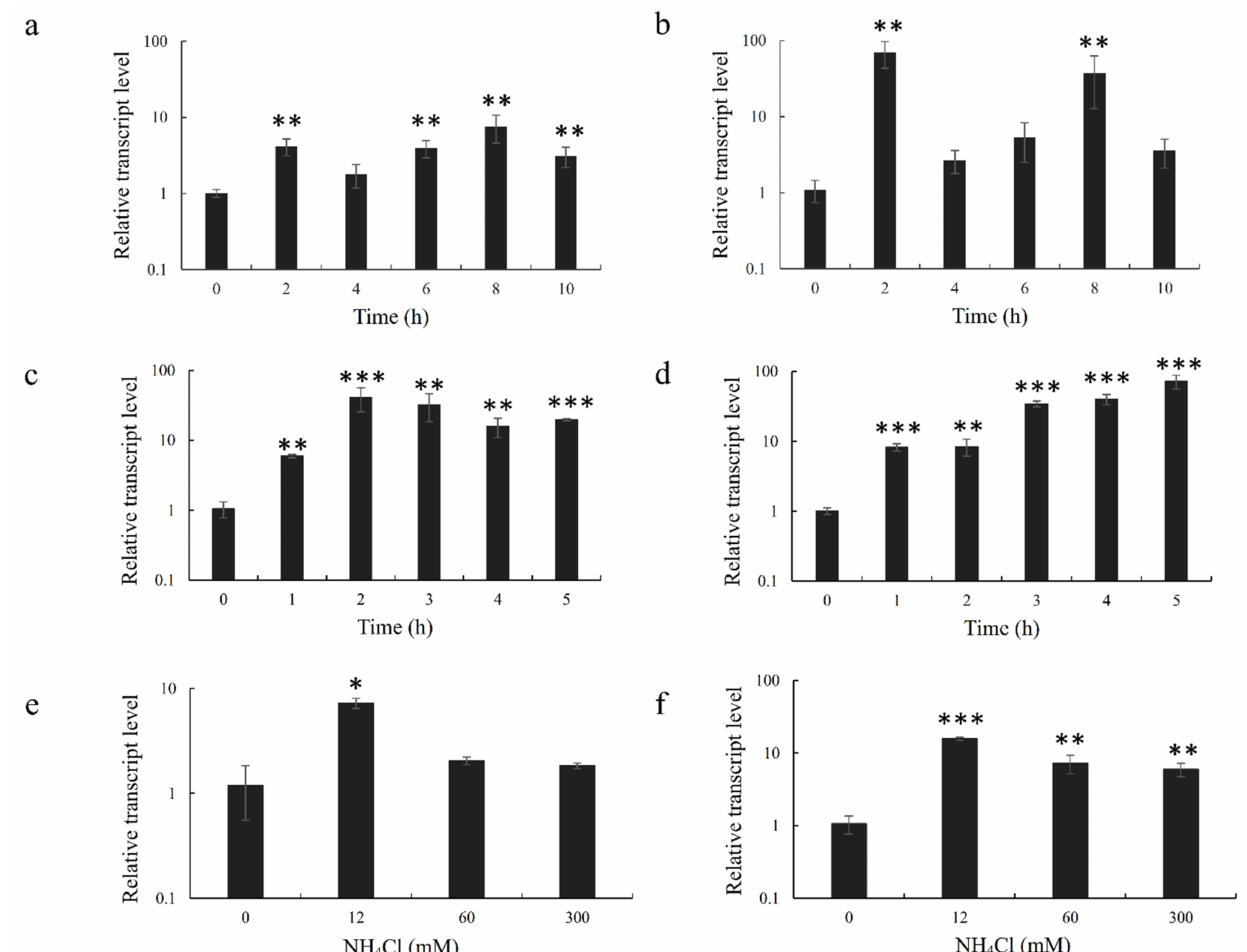
Figure 8. Transcription profiles of PhGDH 1 and PhGDH 2 under drought stress ( a , b ), high-temperature stress ( c , d ), and ammonium salt stress ( e , f ). * p < 0.05, ** p < 0.01, and *** p <